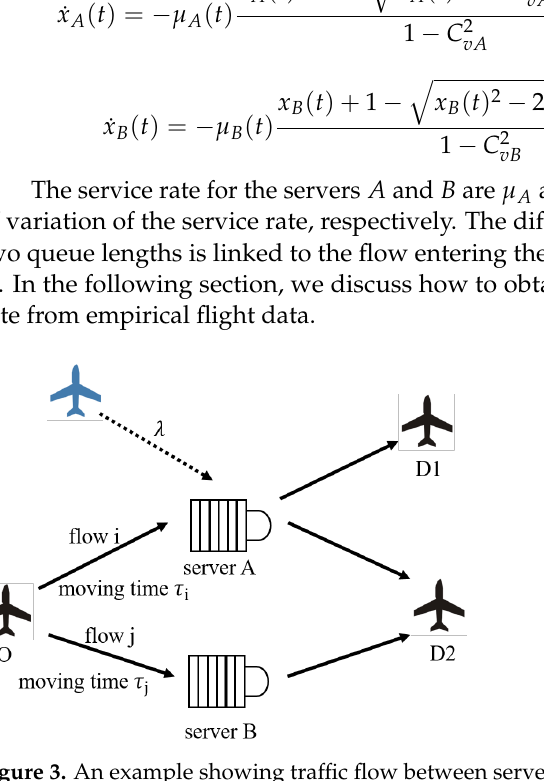
Figure 3. An example showing traffic flow between